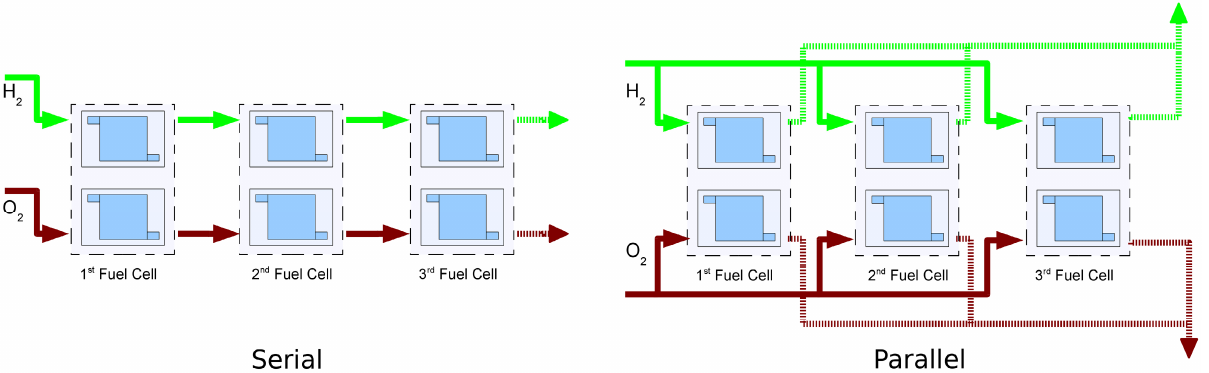
Figure 1. Illustration of serial vs . parallel gas flow topologies: in the case of serial flow, the reactant gases pass from one cell to the next, while in the case of parallel flow, all of the cells are supplied